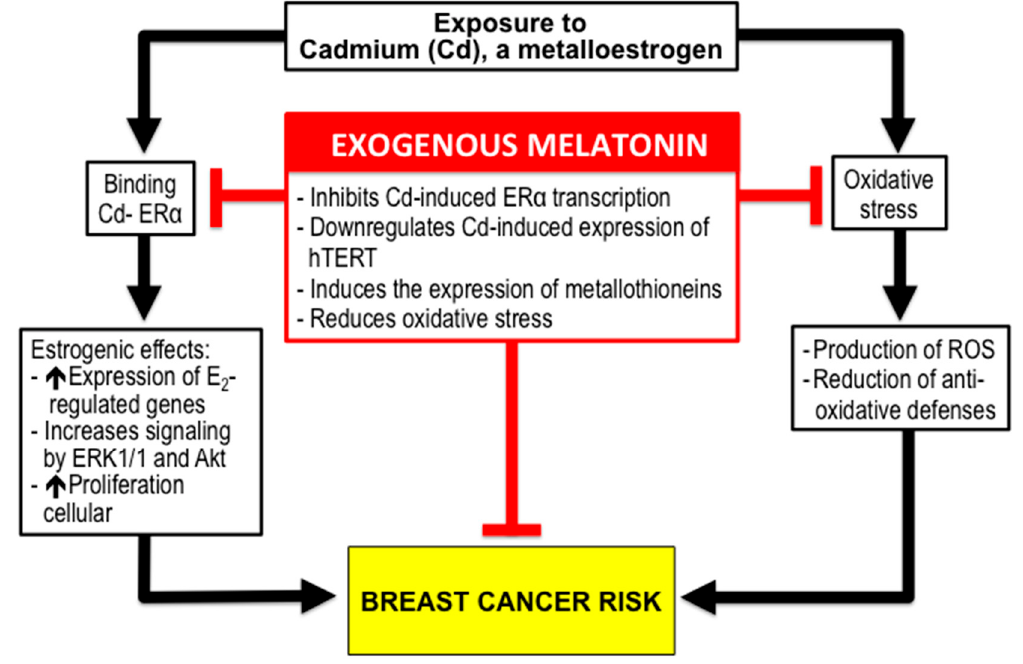
Figure 4. Cadmium, a metalloestrogen, increases the risk of breast cancer by stimulating cell proliferation due to its estrogenic properties, as well as by producing oxidative stress through mitochondrial damage. Melatonin could reduce the risk of breast cancer in individuals exposed to Cd from contaminated food, smoke, or occupational hazards. Melatonin, acts as a specific inhibitor of Cd-induced ER α -mediated transcription in estrogen response elements. Furthermore, melatonin downregulates the hTERT expression induced by Cd and increases the synthesis of metallothioneins, which are proteins involved in Cd detoxification. Moreover, melatonin prevents against Cd-induced oxidative stress.